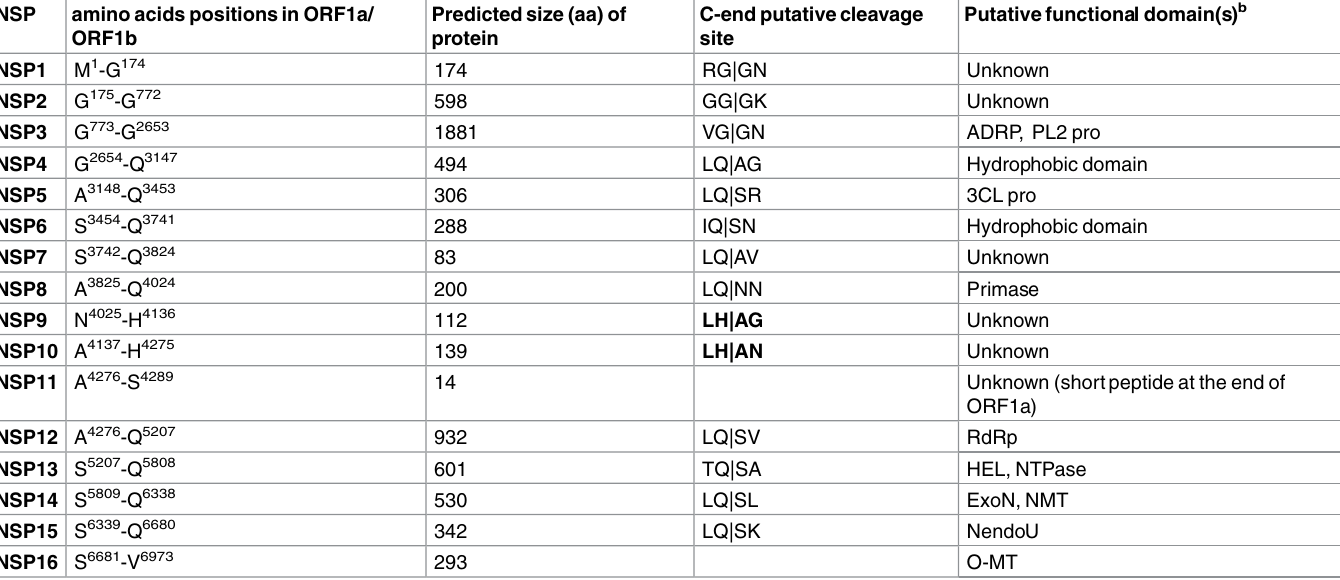
Table 2. Predictionof the putativepp1a/pp1ab cleavage sitesof Ro-BatCoVGCCDC1basedon comparisonwithprototypecoronaviruses a . NSP